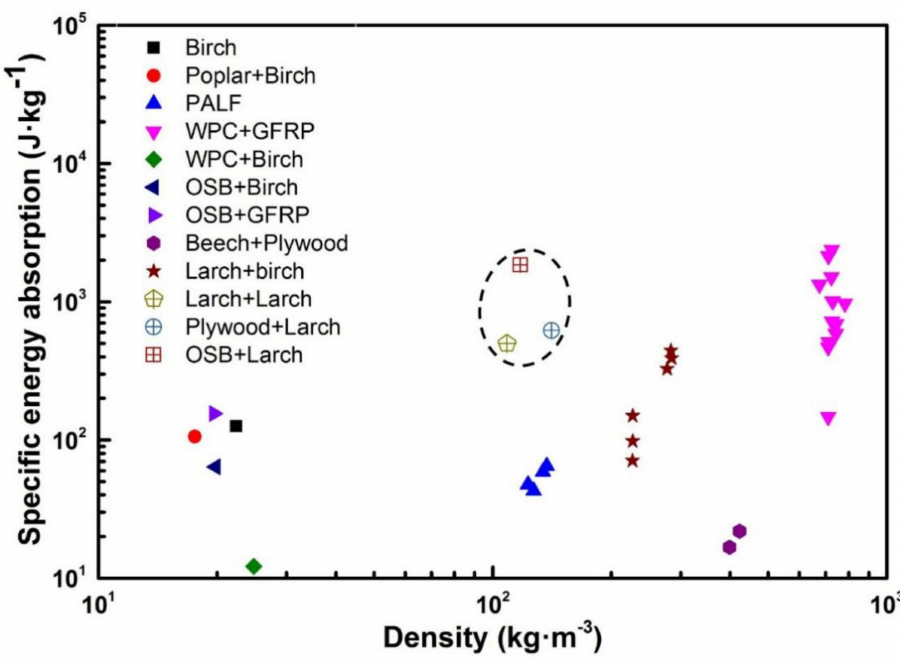
Figure 17. Specific energy absorption of wood-based sandwich